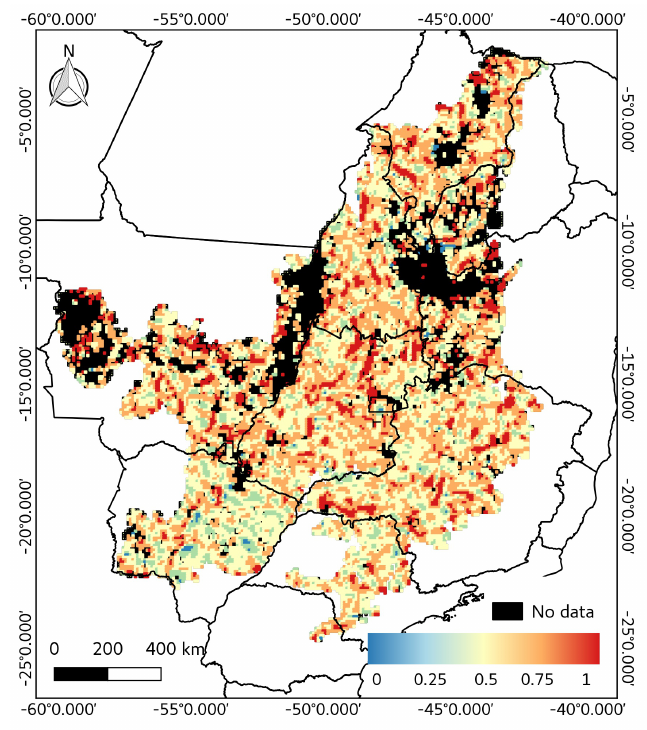
Figure 8. Local coefficients of determination (local R 2